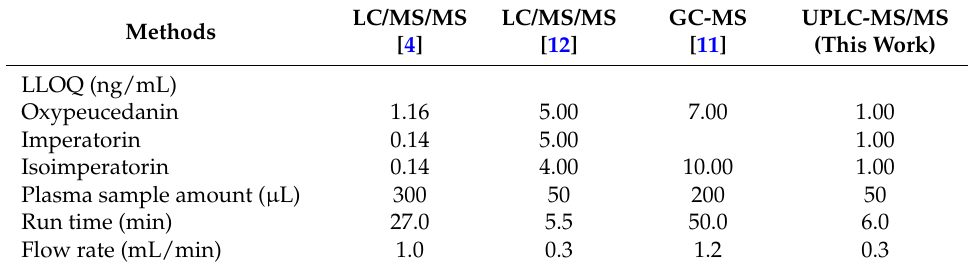
Table 4. Comparison of the developed method and the previous method for determination of three furanocoumarins.